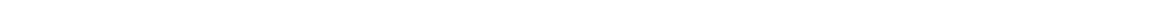
Fig. 6 Myocardial injury activates CM proliferation in neonatal but not adult mice. Neonatal mice underwent left anterior descending artery (LAD) ligation at P1 and clonal analysis performed 21 days post injury. Representative confocal images of a β actin CreER ; R26 VT2/GK , b Nkx2.5 CreER ; R26 VT2/GK and c α MHC CreER ; R26 VT2/GK heart (left ventricle) sections. Insets show close-up of boxed regions. d – f Quanti fi cation of clonal formation following neonatal injury. LAD ligation was performed in 8-week-old mice ( g , h , i ), followed by clonal analysis 3 weeks post-injury. Representative fl uorescent microscope images of the infarct and border zone of g β actin CreER ; R26 VT2/GK , h Nkx2.5 CreER ; R26 VT2/GK and i α MHC CreER ; R26 VT2/GK hearts (left ventricle). j – l Quanti fi cation of clonal formation following adult injury. White dashed line marks infarct area. (Tukey ’ s multiple comparison test), *** p < 0.001 to remote. All measurements shown are depicted as mean ±